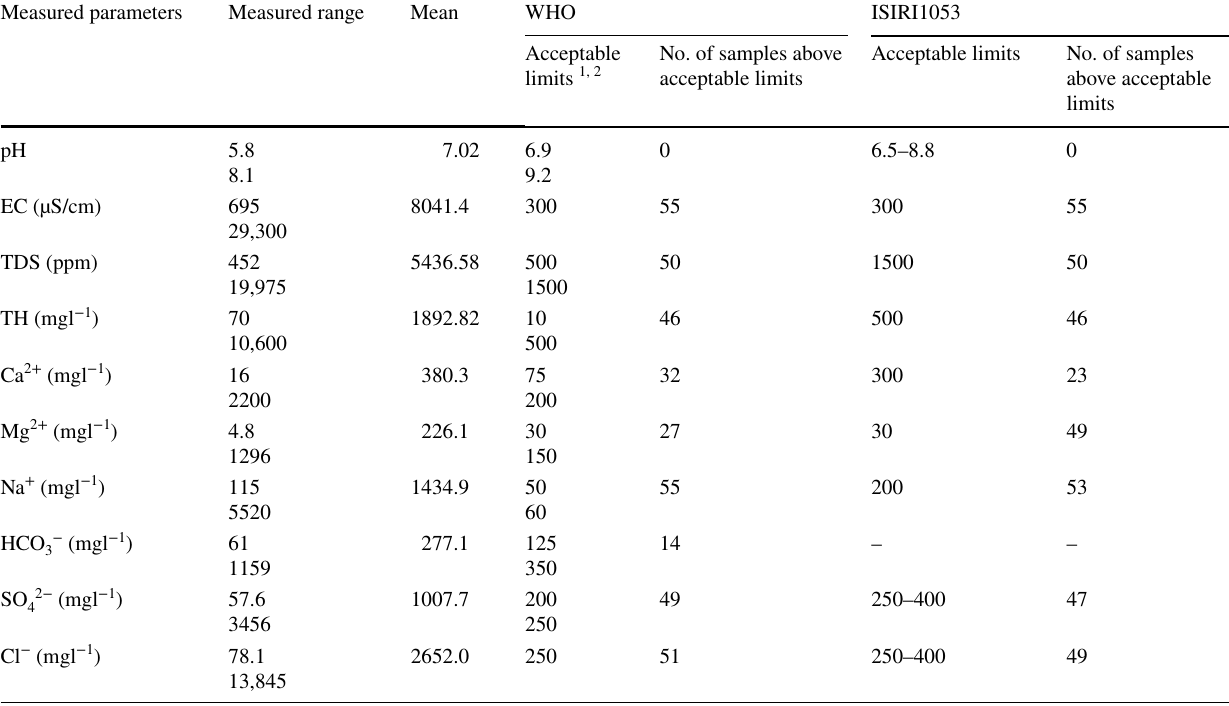
Table 5 Measured ranges of physicochemical parameters of groundwater and comparison with drinking water standards